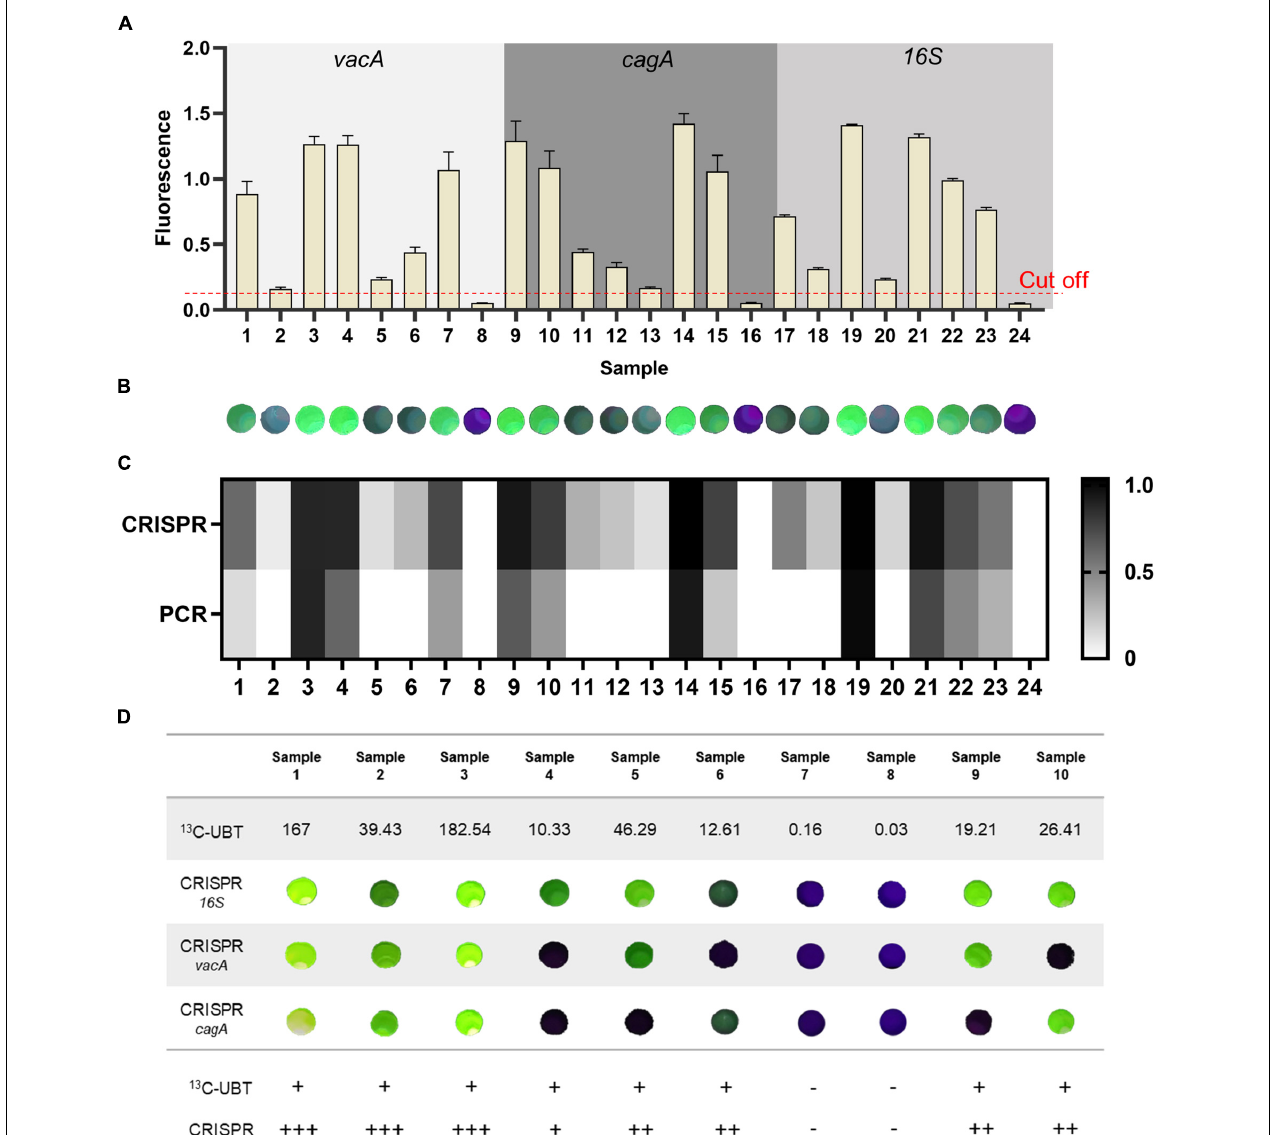
FIGURE 7 | The diagnostic results of the samples by the one-tube RPA-CRISPR platform. The result of the one-tube RPA-CRISPR assay to the mimicked clinical saliva samples based on (A) Light Cycler 480 fluorescence detection System and (B) Pad-VATA (The dashed line indicates the threshold of the positive result). Results are presented as the mean ± SD, and each sample is repeated three times. (C) Comparison results between the one-tube RPA-CRISPR platform for the detection of mimicked clinical saliva samples and qPCR for the detection of different concentrations of plasmids. (D) H. pylori detection in 10 H. pylori -infected clinical samples with proposed one-tube RPA-CRISPR platform and 13 C-UBT. H. pylori positivity was defined based on 13 C-UBT results. The delta over baseline (DOB) value ≥ 4 is positive. +, indicates a positive sample; -, indicates a negative